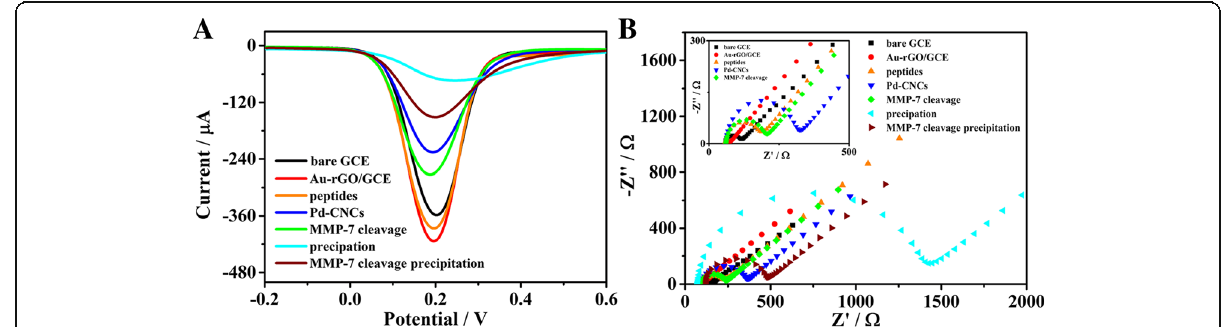
Fig. 4 SWV ( a ) and EIS ( b ) responses of modification process of electrode in 5 mM [Fe(CN) 6 ] 3 − /4- phosphate buffered (0.1 M, pH = 7.4)